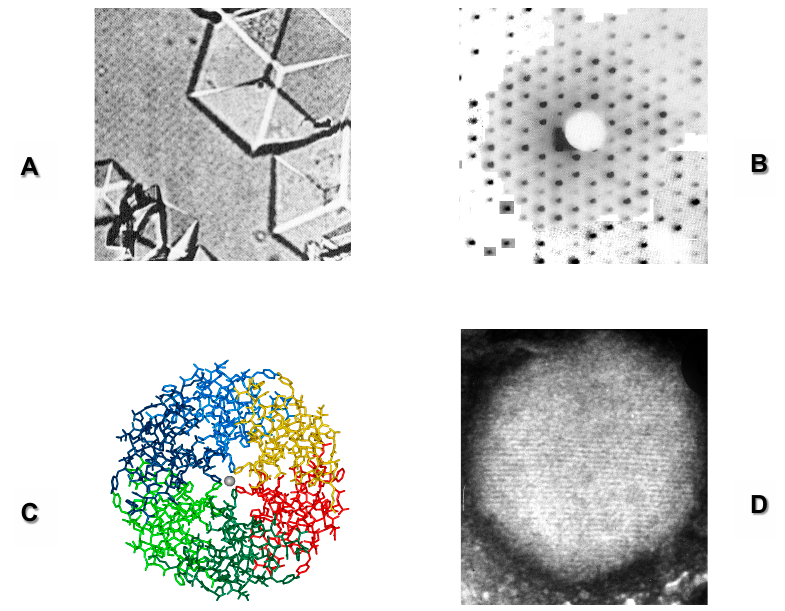
Figure 1. The structure of 2 Zinc-insulin hexamers. ( A ) Rhombohedral crystals used in X-ray analysis and treatment of diabetes. ( B ) An X-ray di ff raction pattern from the rhombohedral crystals, illustrating the 3-fold axis of space group R3. ( C ) Structure of the 2 Zinc-insulin hexamers comprising six insulin molecules and 2 zinc ions. The hexamers of approximate 32 symmetry are viewed down the crystallographic 3-fold axis that relates three dimers, each of which have two protomers related by an approximate 2-fold axis symmetry, perpendicular to the 3-fold axis [12,13]. ( D ) Storage granules in ß-cells of the pancreas, which also contain 2 Zn-insulin hexamers and resemble the crystals used for structure determination’ [14]. ‘